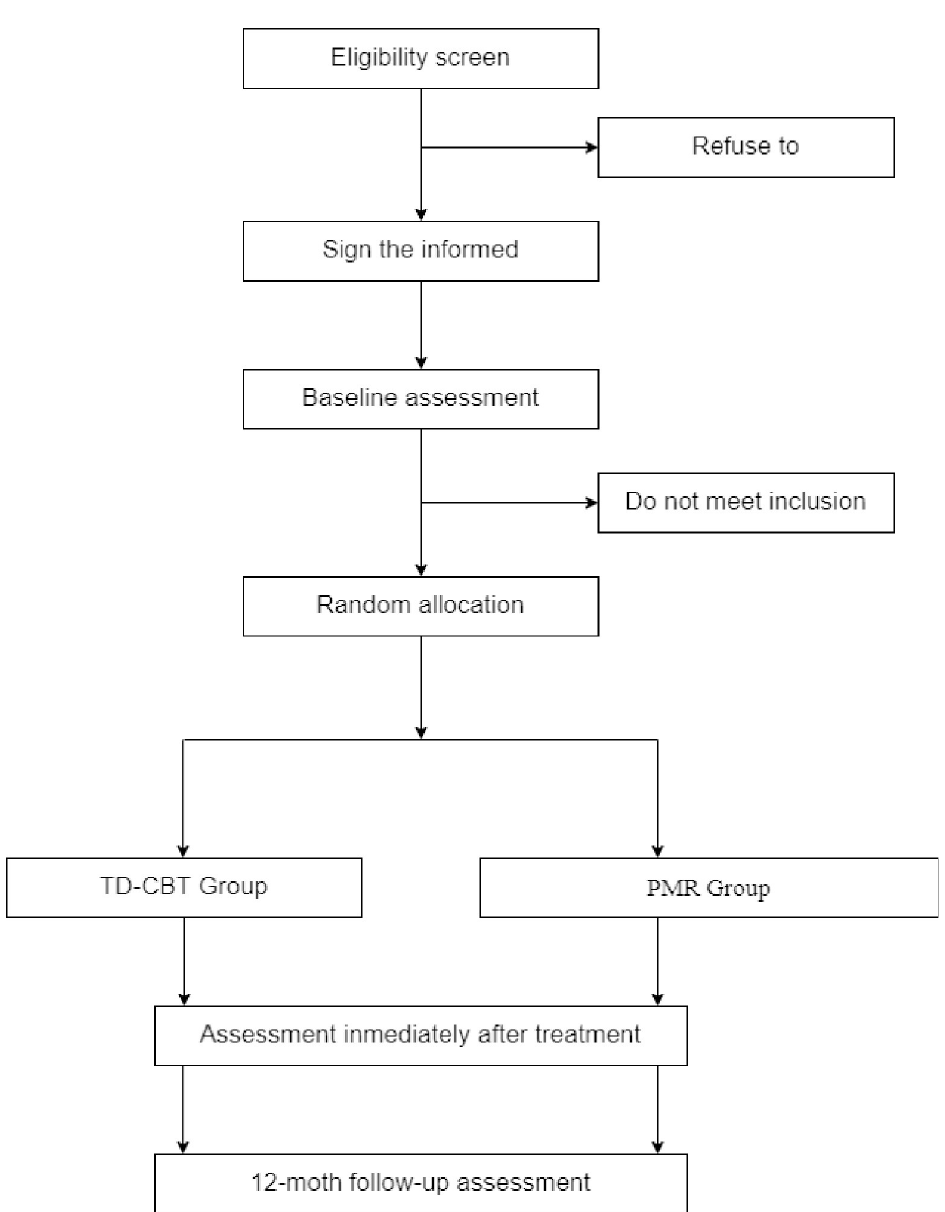
Fig 1. Study design flowchart. TD-CBT: transdiagnostic cognitive-behavioural therapy; PMR: progressive muscle relaxation.